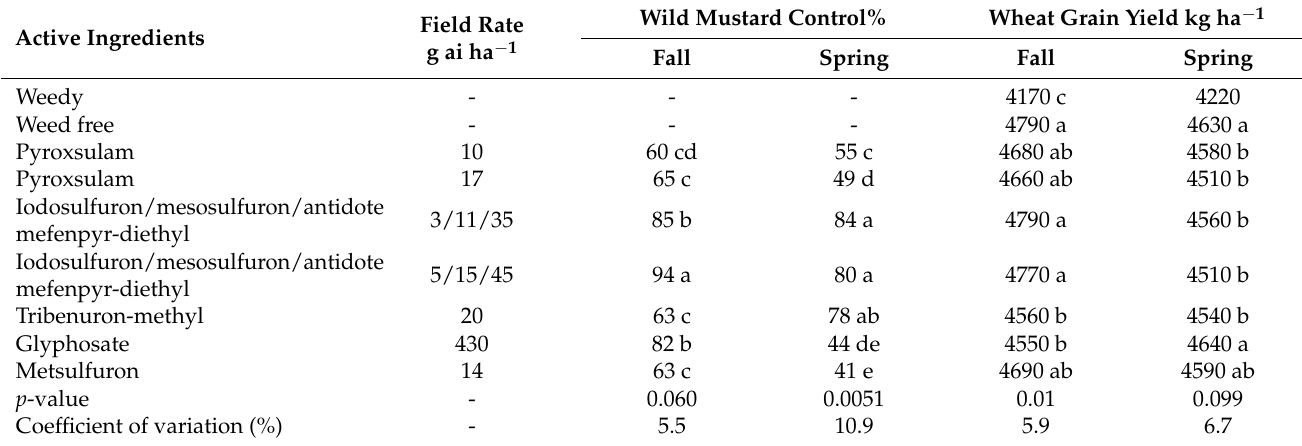
Table 4. Wild mustard control and wheat grain yield after fall and spring herbicide applied preplant at Kashira 2019. Active Ingredients